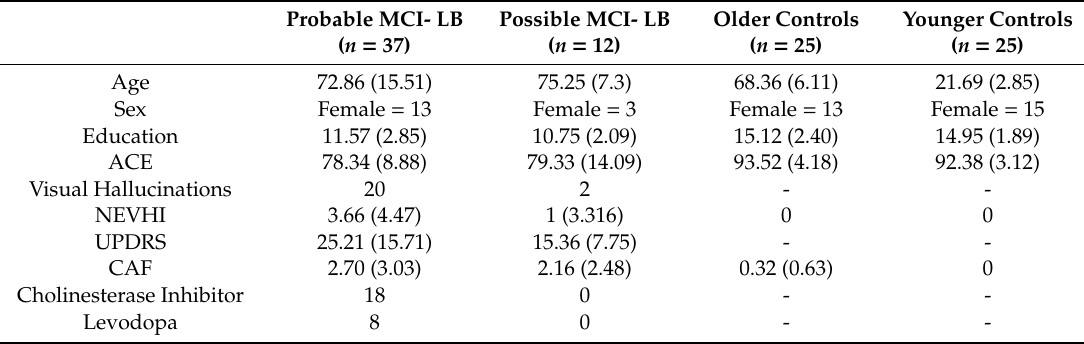
Table 1. Demographic information of Lewy-Pro cohort and control participants. ACE = Addenbrooke’s Cognitive Examination, NEVHI = North East Visual Hallucinations Inventory, UPDRS = Unified Parkinson’s Disease Rating Scale, CAF = Clinical Assessment of